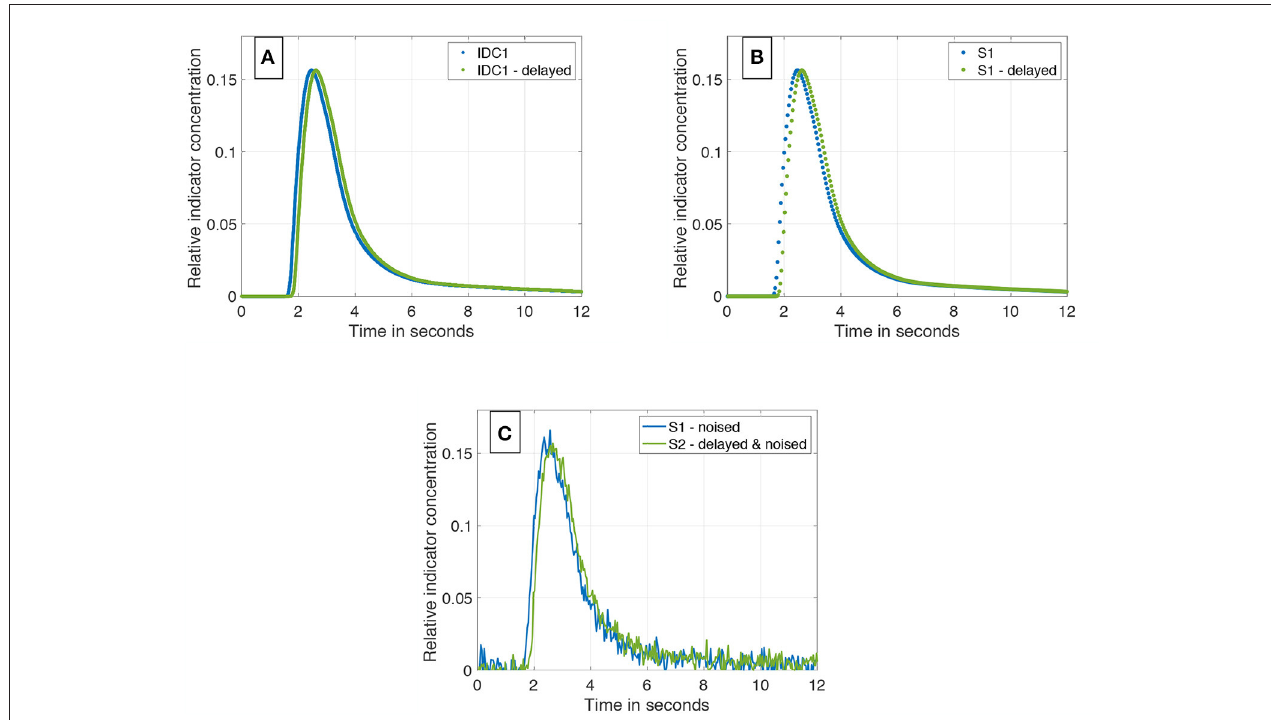
FIGURE 4 | (A) IDC1 in blue without any manipulations. In green, the same curve delayed by a transit time 1 t Sub-sampling of the two curves from (A) . Both curves are sub-sampled to 25 Hz . (C) Final data set containing two differently sub-sampled curves; one of them temporally shifted by the ground truth transit time 1 t . White Gaussian noise is applied to both IDCs ( SNR